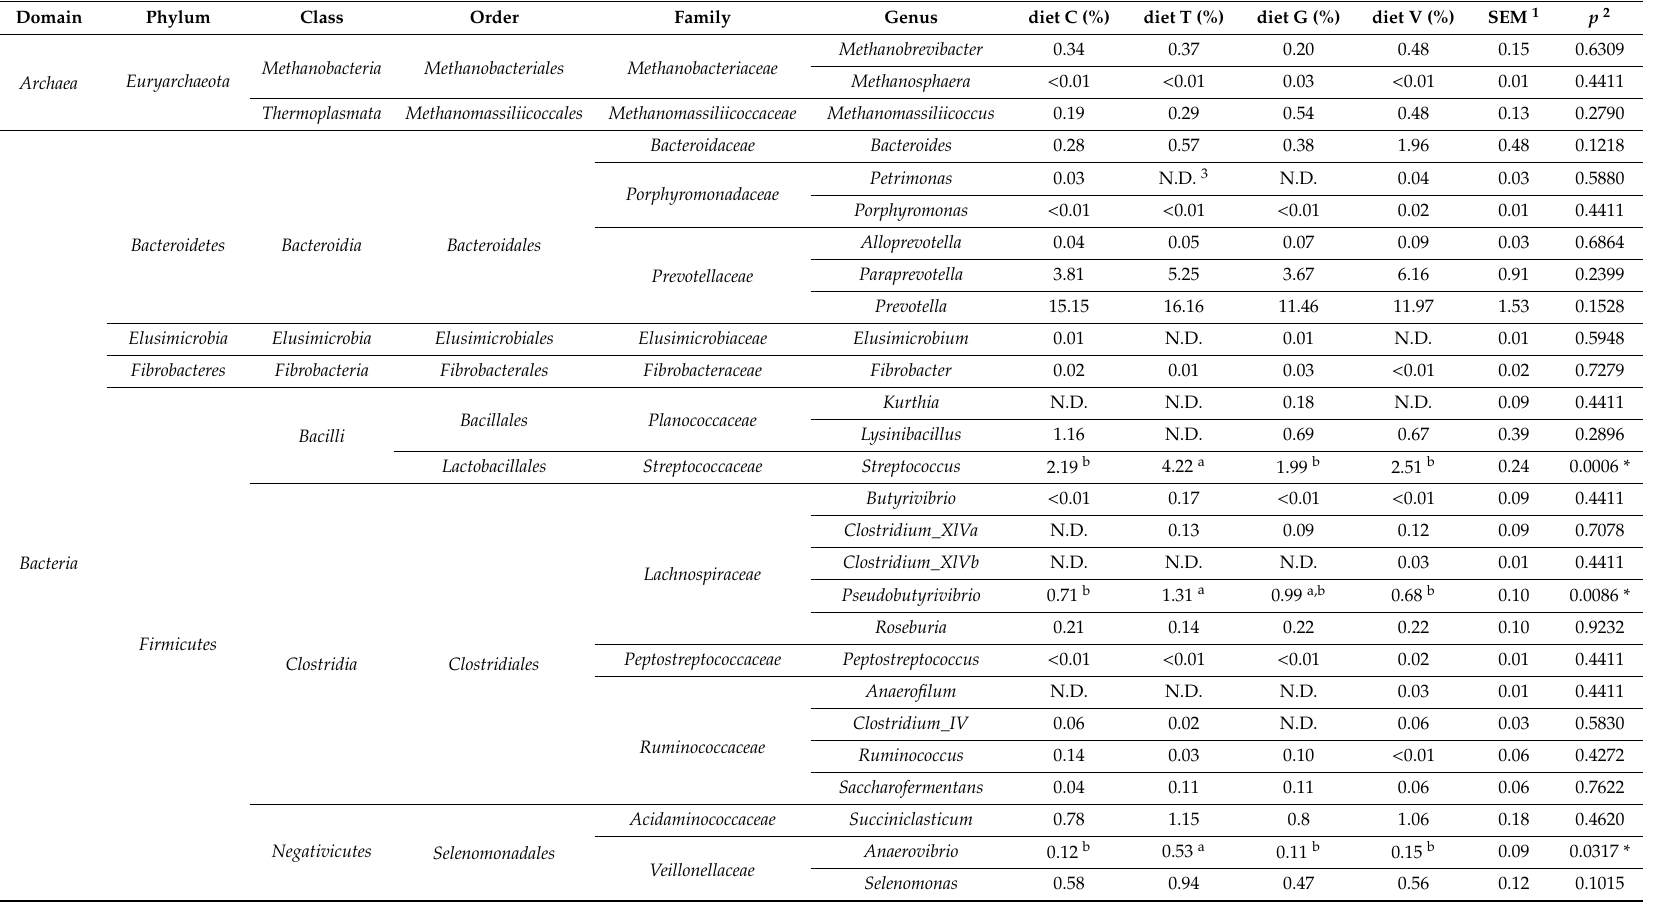
Table 5. Relative abundance of the microorganisms classified at genus level (confidence